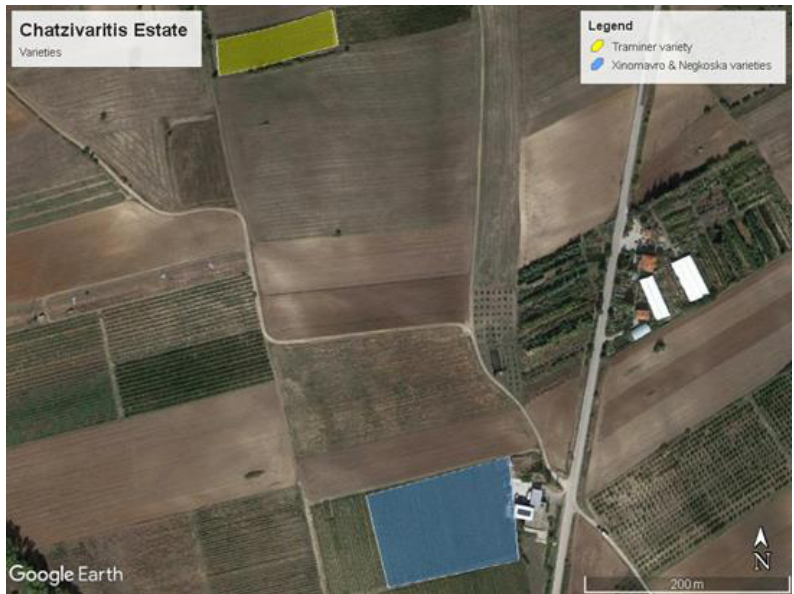
Figure 1 . Chatzivariti’s vineyard showi ng the vineyards where the images of diseased vine leaf were obtained. were